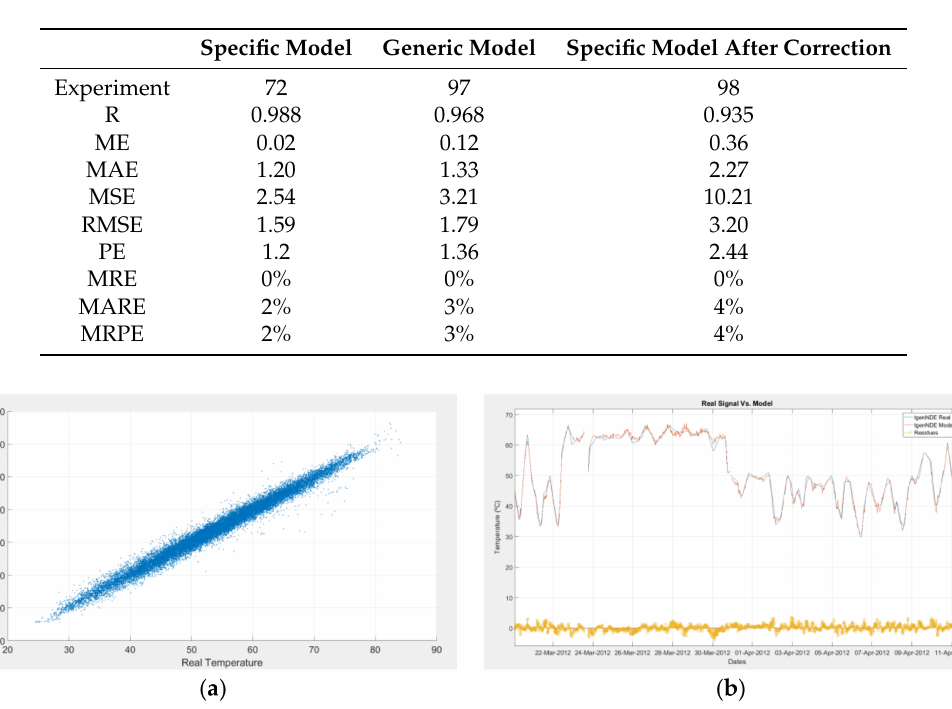
Table 3. Errors obtained in the different models developed.